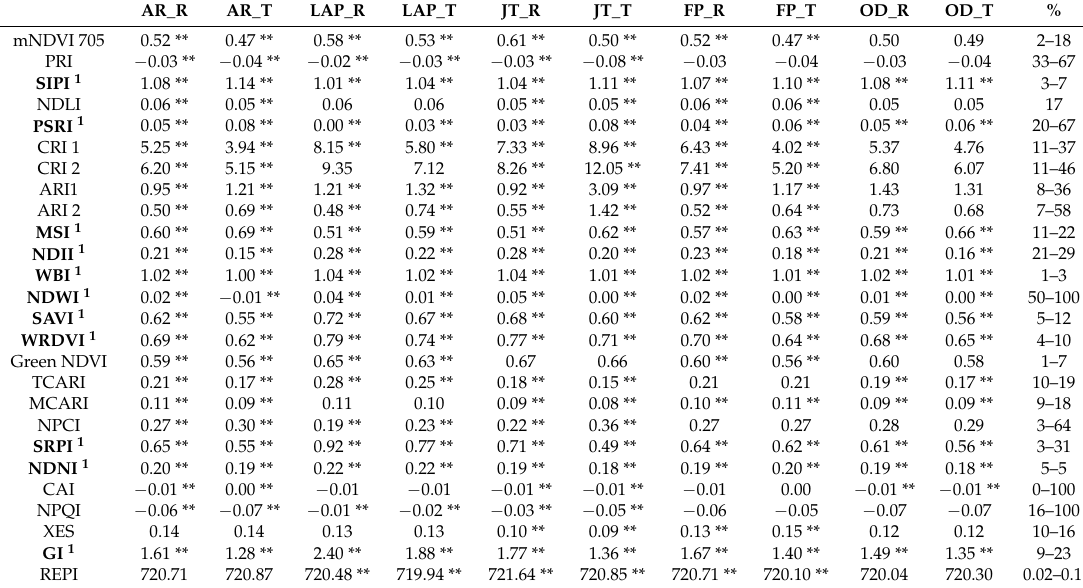
Table 3. Remote sensing vegetation indices for the species showing statistically significant changes at the 0.05 level. AR, Agrostis rupestris ; LAP, Luzula alpino-pilosa ; JT, Juncus trifidus ; FP, Festuca picta ; OD, Oreochloa disticha ; T, trampled; R, reference; **, statistical significance at the 0.05 level; %, the percentage of trampled is smaller than the reference value for all species; 1 , bold indices mean statistically important difference between two types of polygons for all